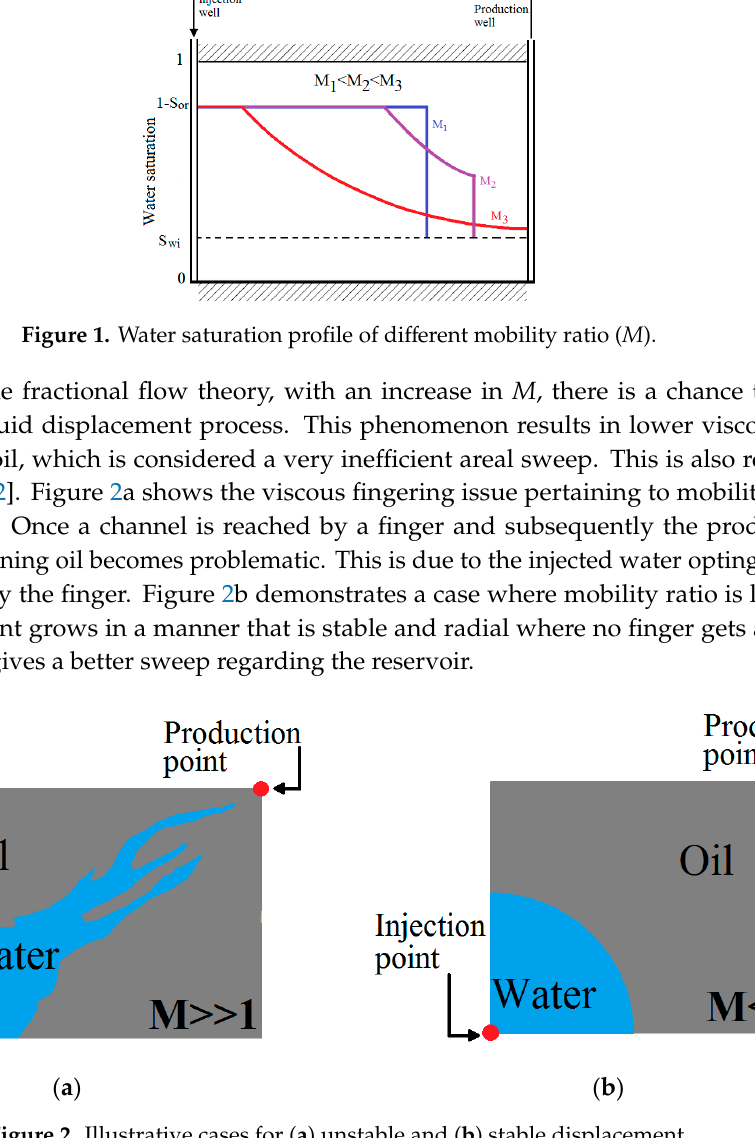
Figure 2. Illustrative cases for ( a ) unstable and ( b ) stable displacement.